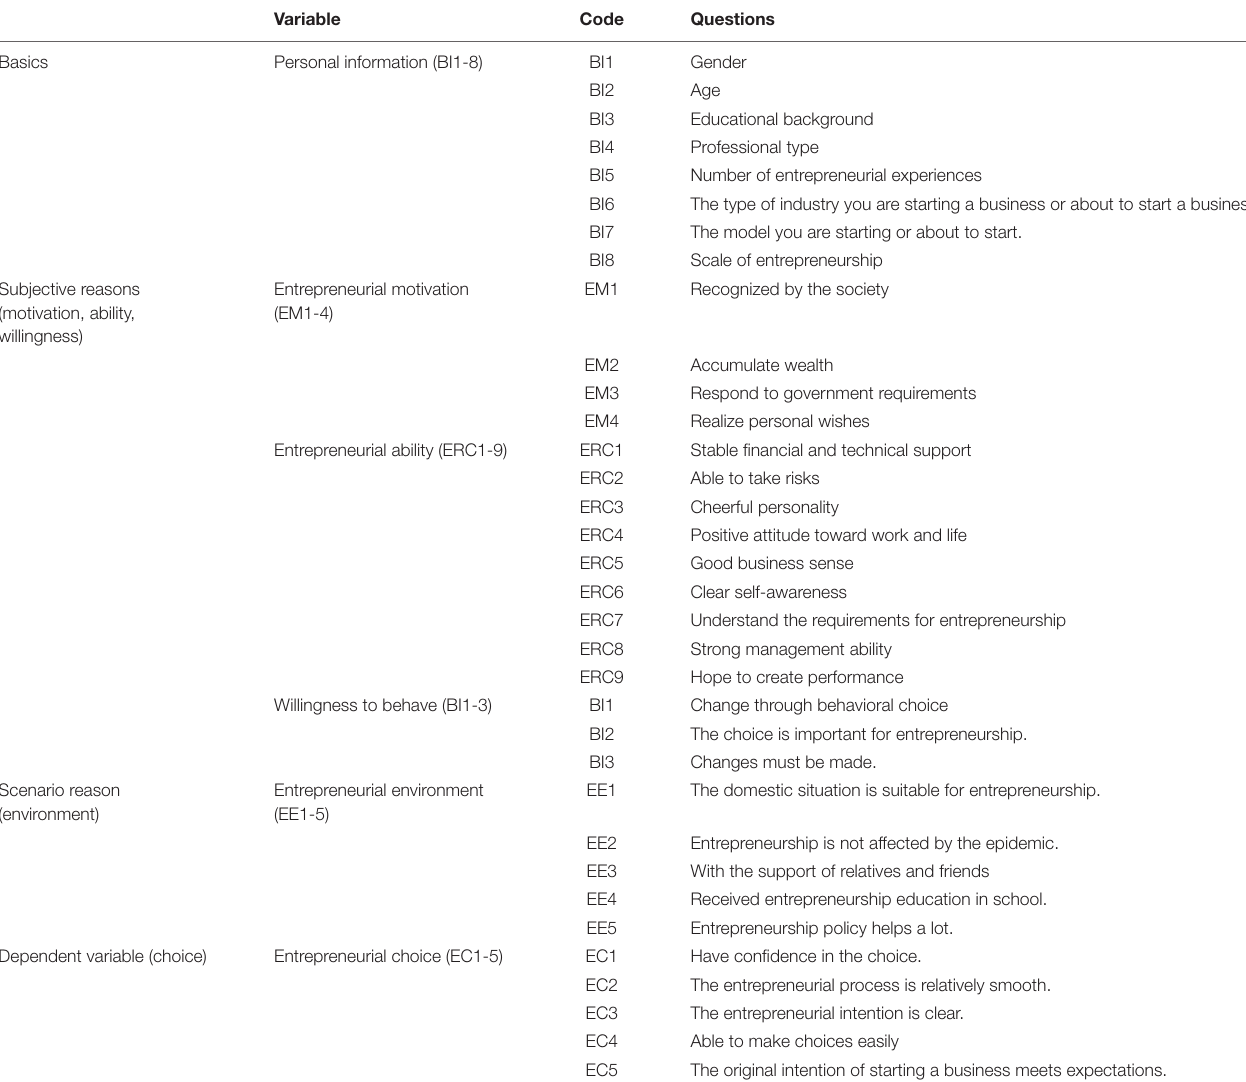
TABLE 1 | The initial scale of influencing